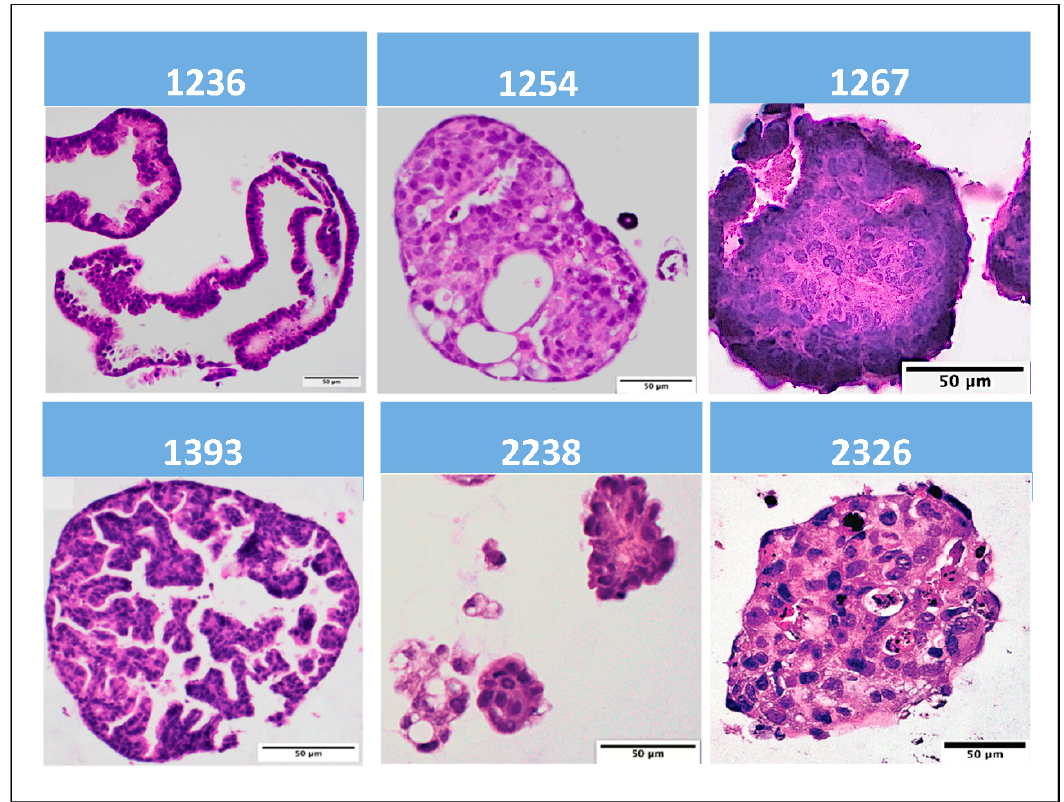
Figure 1. Hematoxylin and eosin (H&E) micrographs of established epithelial ovarian cancer tumor organoids.